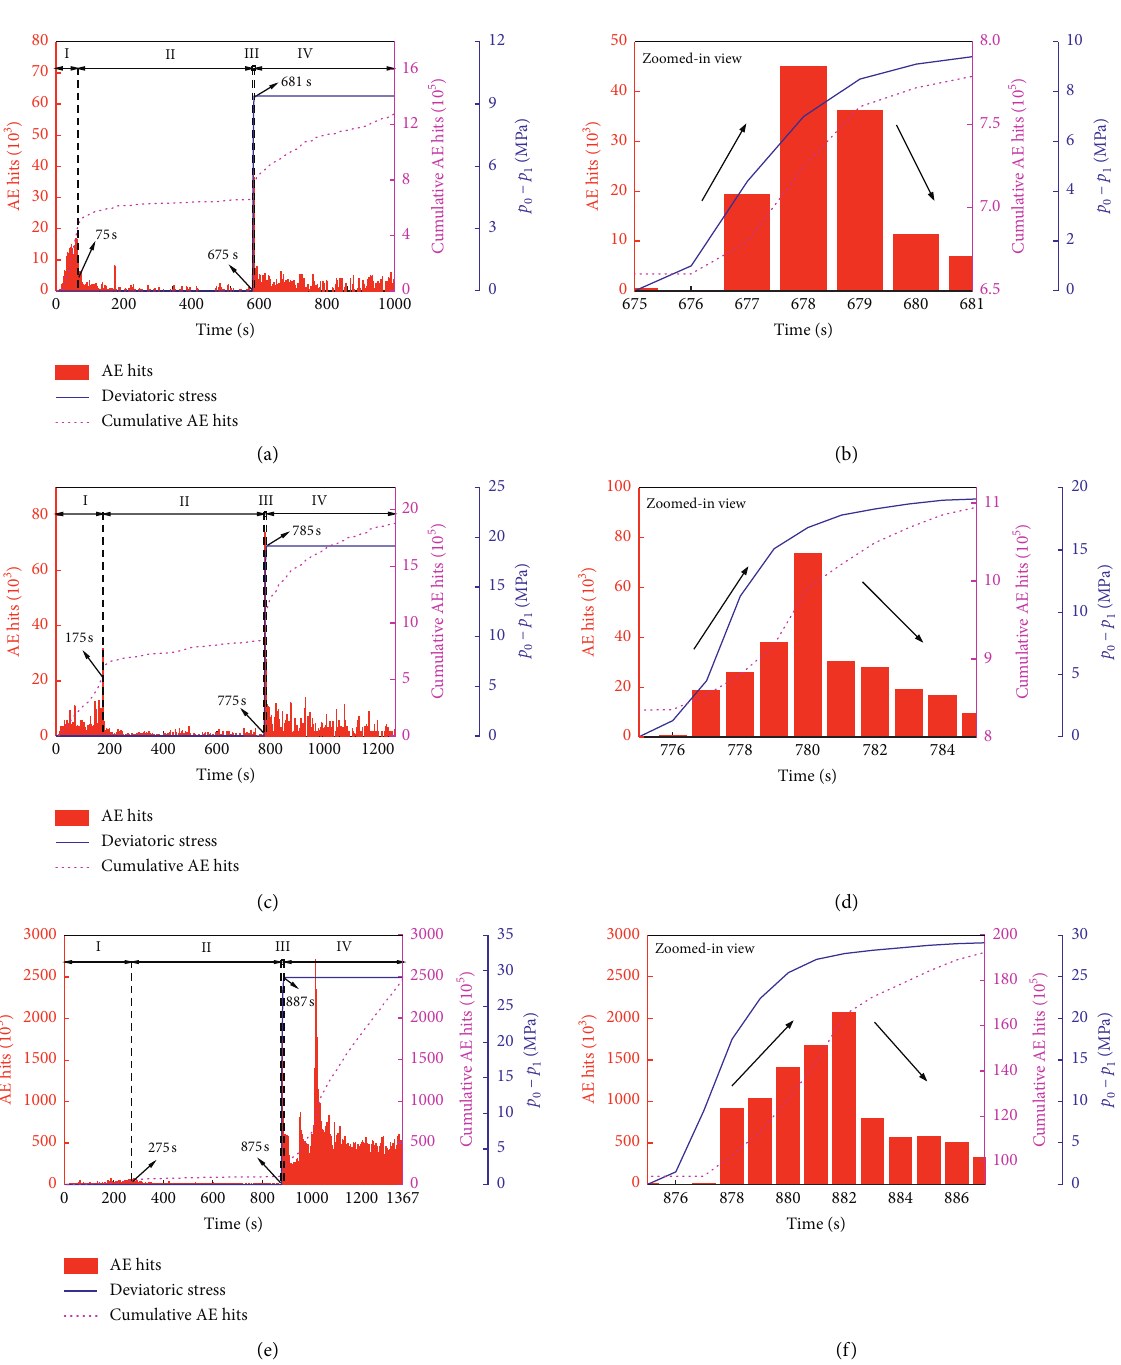
Figure 8: Evolution of AE hits in whole tests process for specimens under different initial confining stress ((a) and (b) 10, (c) and (d) 20, and (e) and (f)